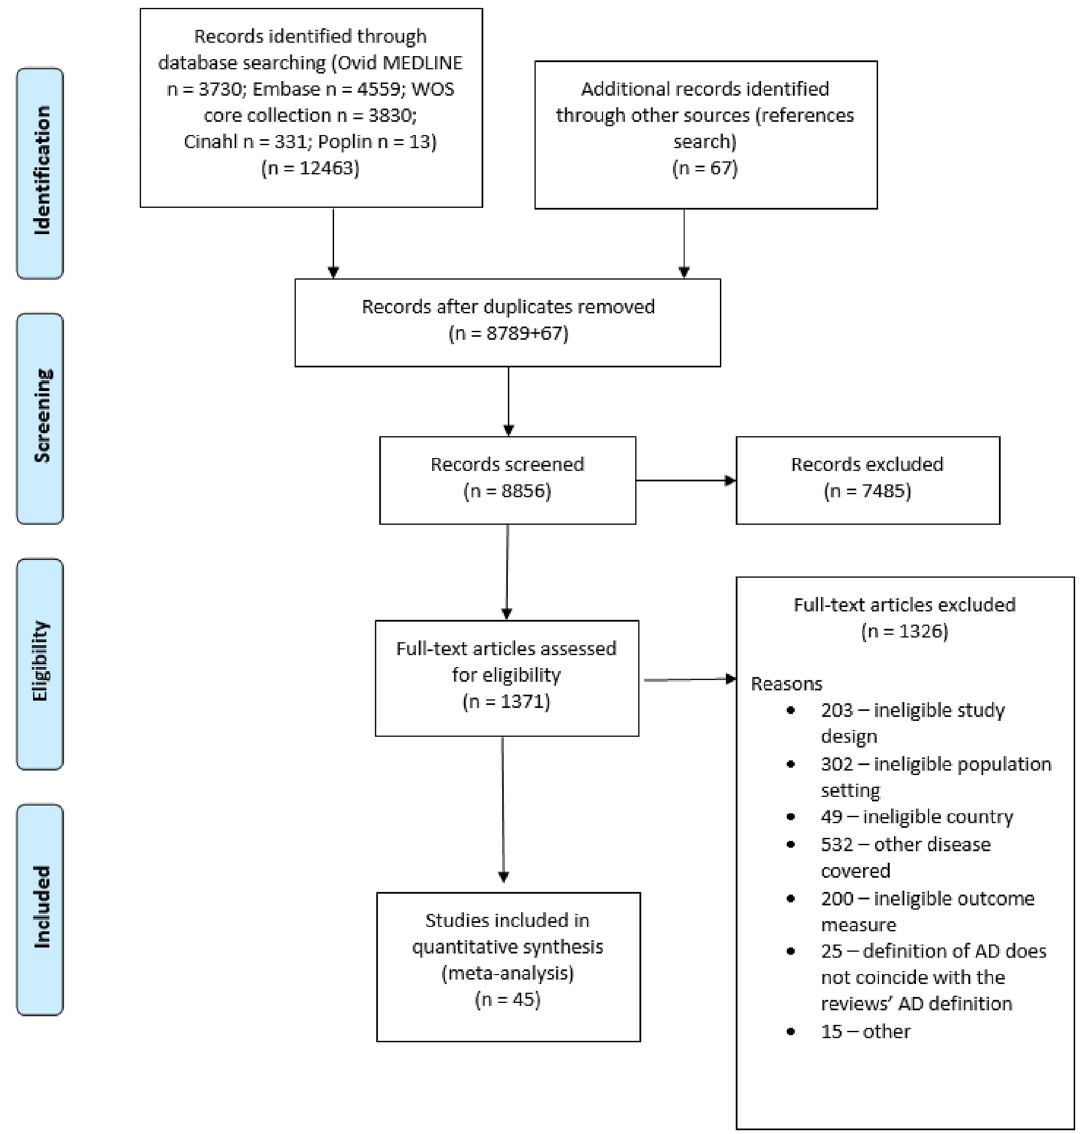
Figure 1. The study selection process for the systematic review and